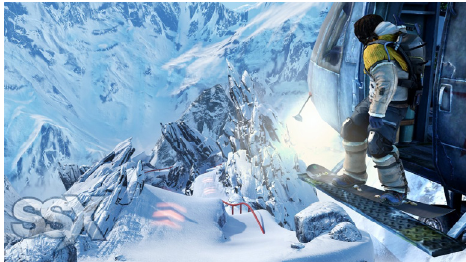
Fig. 6. Visualization from SSX game by EA Games